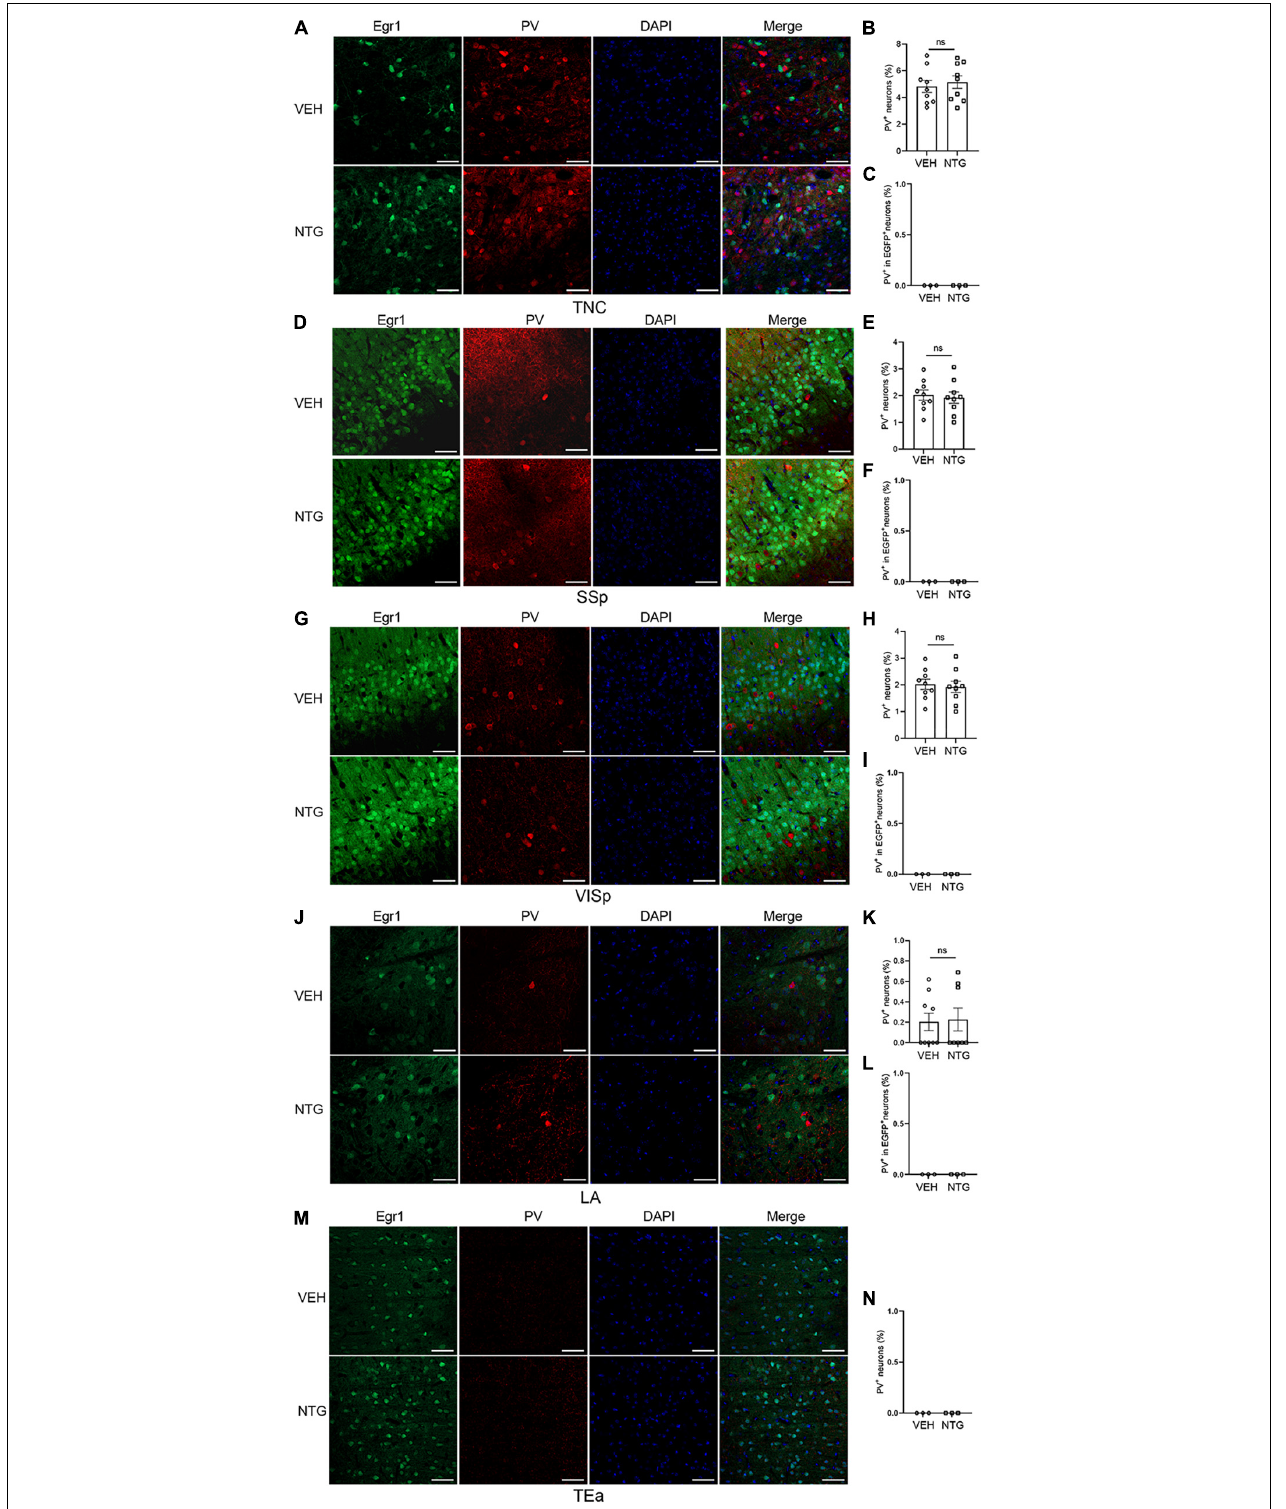
FIGURE 4 | Most of the Egr1-EGFP positive neurons in neocortex and LA were not PV + interneurons. Immunofluorescence staining images were shown on the left (A,D,G,J,M) . Quantitation of PV + neurons (B,E,H,K,N) and the data of PV + - EGR1 + co-localization (C,F,I,L) are shown on the right. Student’s t -test. n = 3/group. Scale bars = 50 µ m. Egr1, early growth response protein 1; TNC, trigeminal nucleus caudalis; SSp, primary somatosensory cortex; VISp, primary visual area; LA, lateral amygdala nucleus; TEa, temporal association areas.